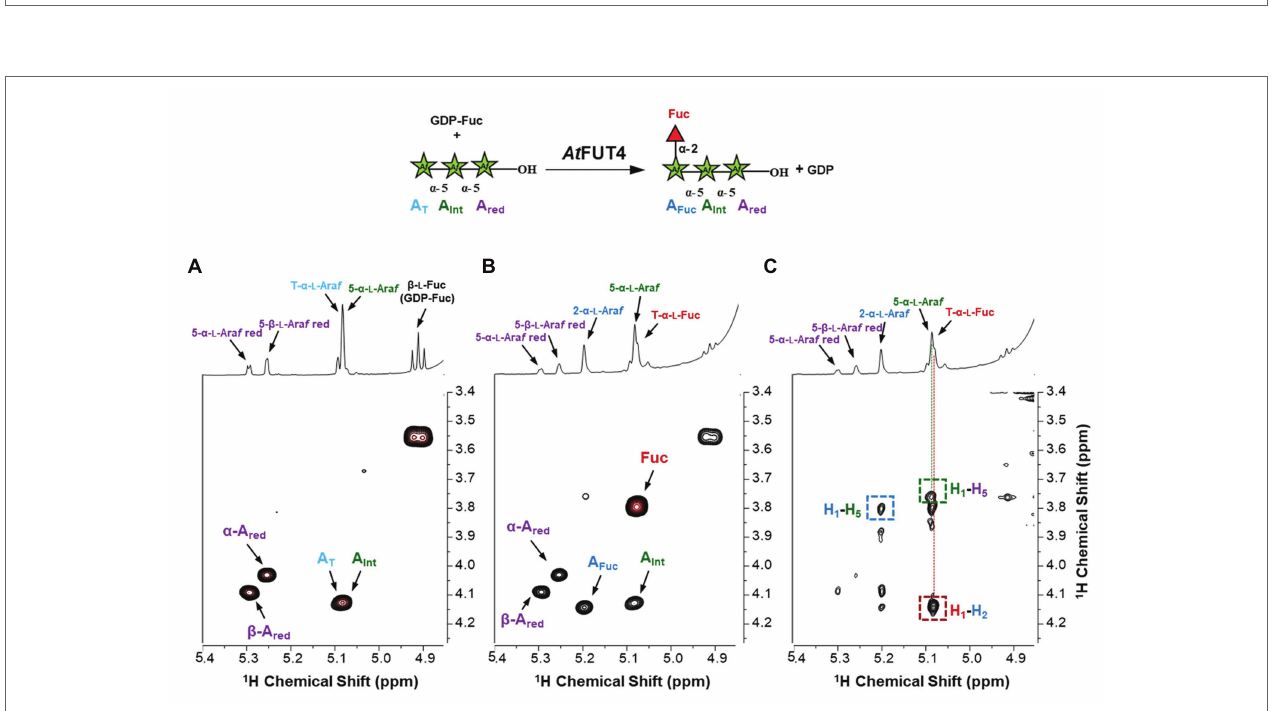
FIGURE 7 | NMR analysis of the products formed when arabinotriose was incubated with GFP- At FUT4 and GDP-Fuc. The scheme of the reaction is shown at the top of the figure. The labeled cross-peaks in the two-dimensional COSY spectrum of the control (A) correspond to the anomeric signals of the residues of the arabinotriose. After the reaction with GFP- At FUT4, the COSY spectrum (B) contained two additional signals, which were identified as terminal Fuc and an Ara with Fuc attached at O 2. The signals surrounded by squares in the NOESY spectrum of the GFP- At FUT4 reaction (C) indicate the glycosidic linkages in the enzymatically-generated fucosylated oligosaccharide. For the complete list of assignments, see Supplementary Table S2